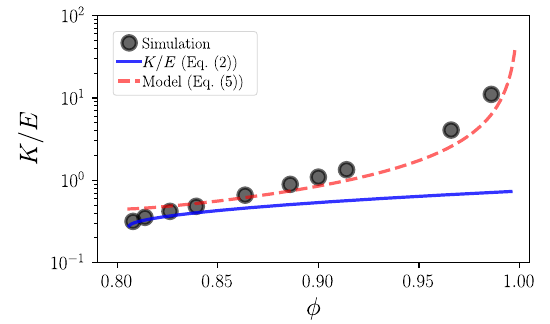
Figure 1. Screenshots of a sample under a relative pressure P / E = 5 10  4 (left), and P / E = 5 10  1 (right). The in- ⇥ ⇥ Figure 2. Evolution of the bulk modulus during compaction in tensity of the color is proportional to the volumetric strain within our experiments (black disks), and the predictions given by Eqs. the particles. (2) and (5) with a dashed blue and red lines,